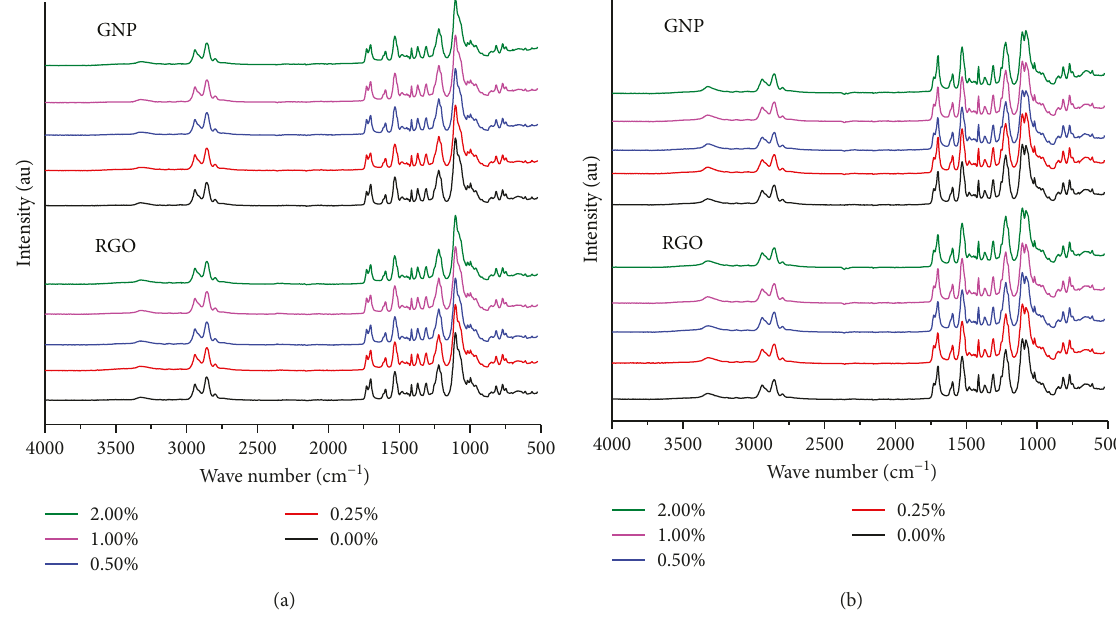
Figure 7: FTIR for (a) PU20 and (b) PU40